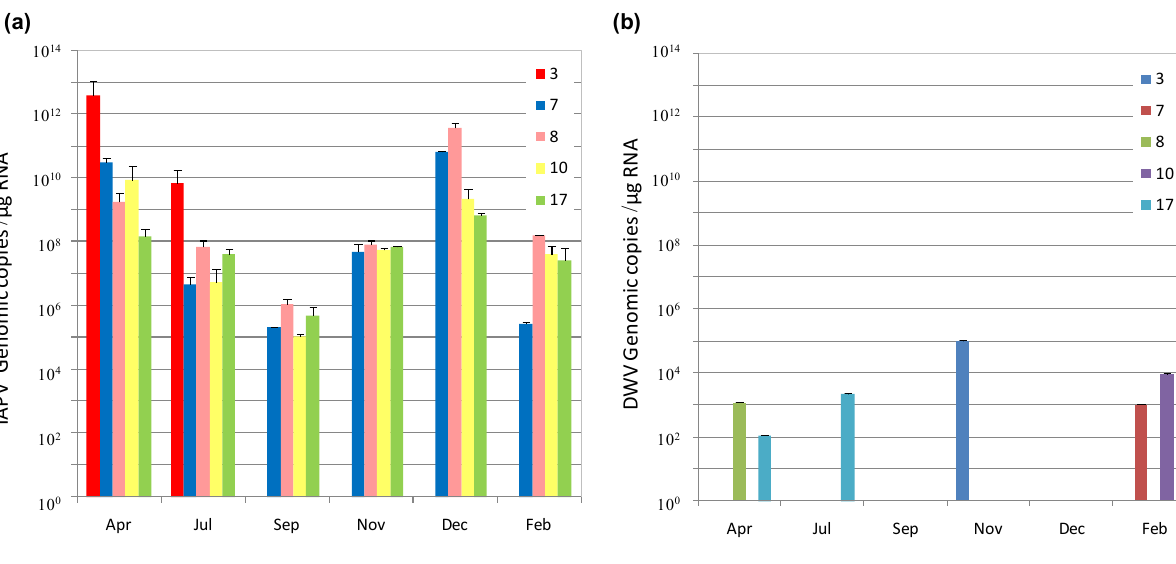
Figure 1. Loads of Israeli Acute Paralysis Virus (IAPV) and Deformed Wing Virus (DWV genomic copies in honey bee samples from CCD- and IAPV- bearing colonies over time. ( a ) IAPV. ( b ) DWV. The viral genomic copy number was determined by RT-qPCR as described in Materials and Methods. Colored bars, different colonies. Each bar represents the average viral load (±SD) of a pool of 10 bees (three replicates). ( a ) The levels of virus varied significantly per colony (colony 3 different from the rest) and per month. (September significantly lower than the rest; April and December significantly higher than the rest) Colony F = 5.8, d.f. = 4,16, p < 0.01; Month F = 17.2 d.f. = 4,16, p < 0.01, (GLM, Post-hoc test: